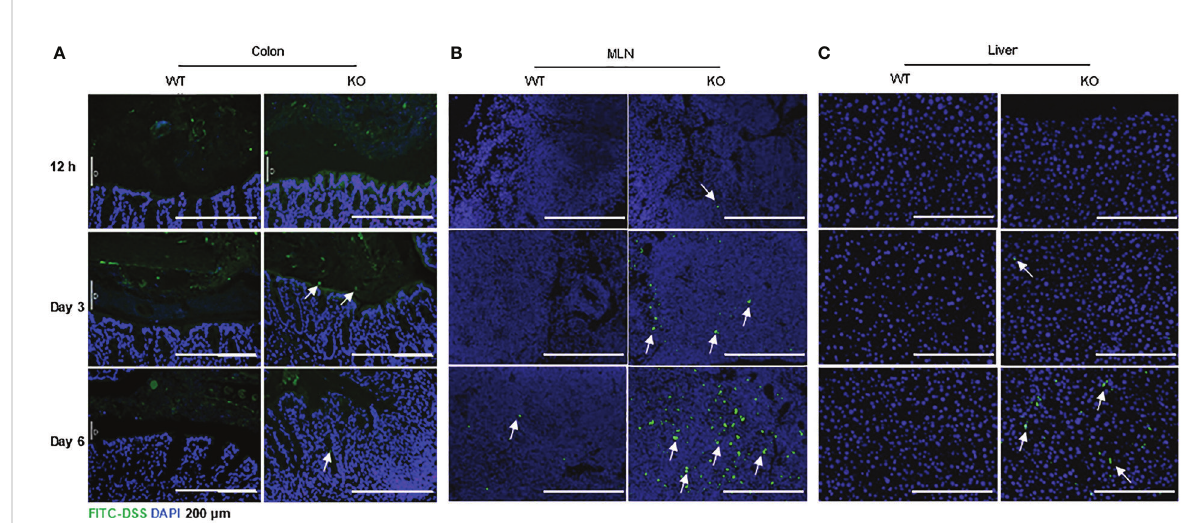
FIGURE 4 Increased FITC-DSS penetration into colon, MLN and liver of AKR1B8 KO mice. FITC-labeled dextran was administered and its penetration into the organs was evaluated as described in the Materials and Methods. Nuclei were stained with DAPI (Blue). (A) colonic mucosa, (B) Mesenteric lymph nodes (MLNs), and (C) liver. Arrows indicate the FITC-dextran. Scale bars, 200 m m. KO, knockout; WT, wild